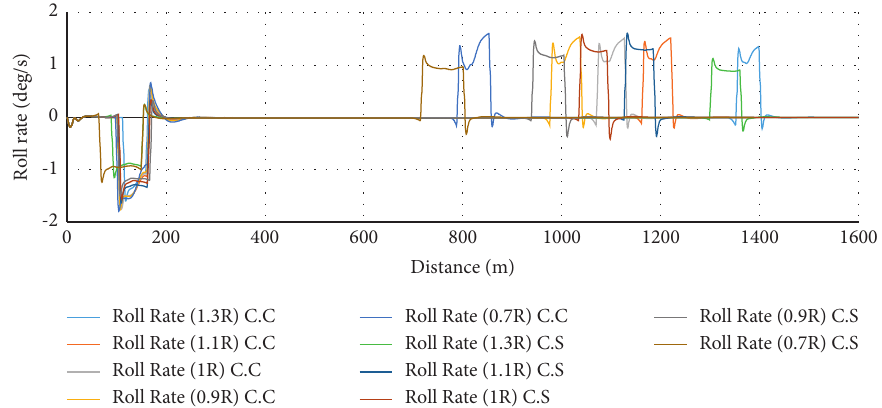
Figure 12: Roll rate for various radii of simple and spiral horizontal curves for SUV vehicles; C.C is the simple horizontal curve, and C.S is the spiral horizontal